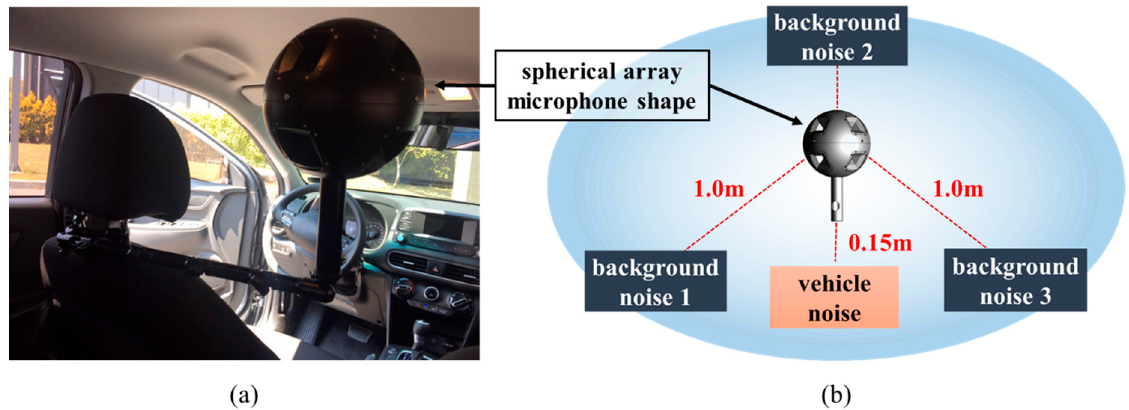
Figure 1. Experimental set-up: ( a ) measurement environment, ( b ) data acquisition background noise locations and environment configuration.